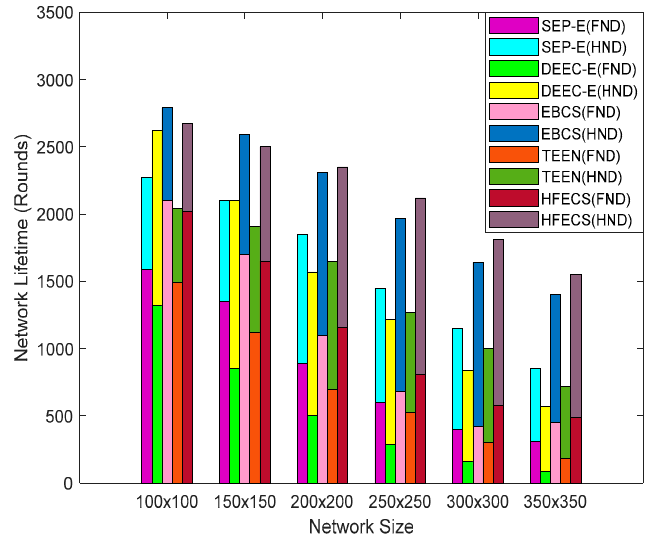
Figure 8. Network lifetime in terms of first node dead (FND) and half nodes dead (HND) against variable network size. Table 12. Percentage improvement of HFECS in terms of network lifetime (FND).